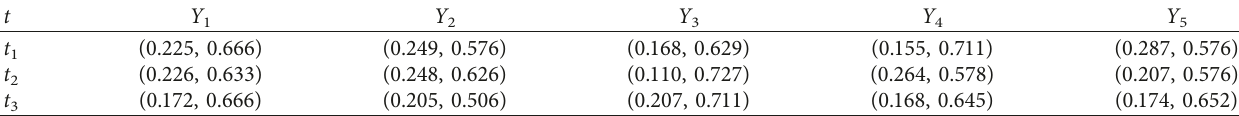
Table 3: ATS-GWIFBM operator decision matrix.